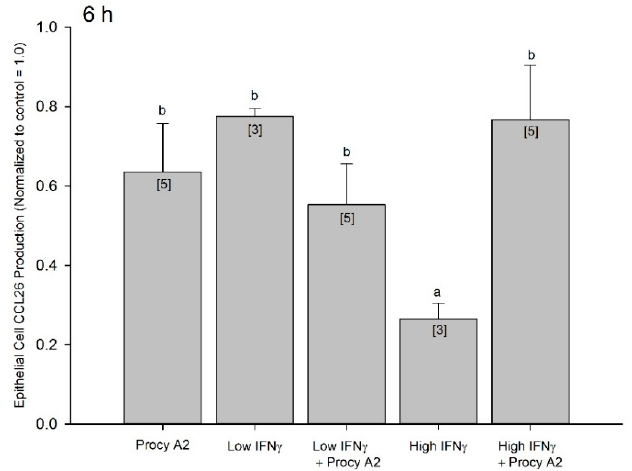
Figure 6. Concomitant incubation (6 h) of procyanidin A2 and IFN γ does not improve inhibition of CCL26 production. A549 cells were seeded at 5 × 10 5 in 12-well plates, serum starved for 24 h and incubated for 6 h with either 5 μ M procyanidin A2 (Procy A2), low (0.5 nM), high (5.8 nM) IFN γ alone, or concomitantly IFN γ plus 5 μ M procyanidin A2. Cells were washed and then stimulated with 5 ng/mL IL-4 for 24 h. Collected supernatants were measured for CCL26 by ELISA. Results are expressed as mean ± SEM normalized to control = 1.0, which were from 3–5 separate experiments and 9–15 individual measurements. Brackets, [ n ], indicate number of experiments for each data point. Different letters “a” and “b” represent statistical difference, p < 0.05.